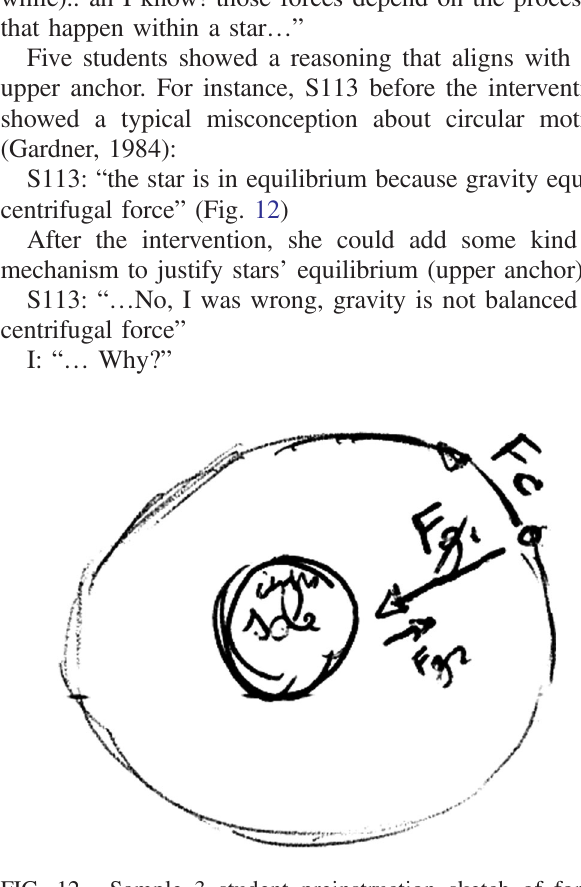
FIG. 12. Sample 3 student preinstruction sketch of forces acting on a small volume element of the Sun. Translation of Italian label: